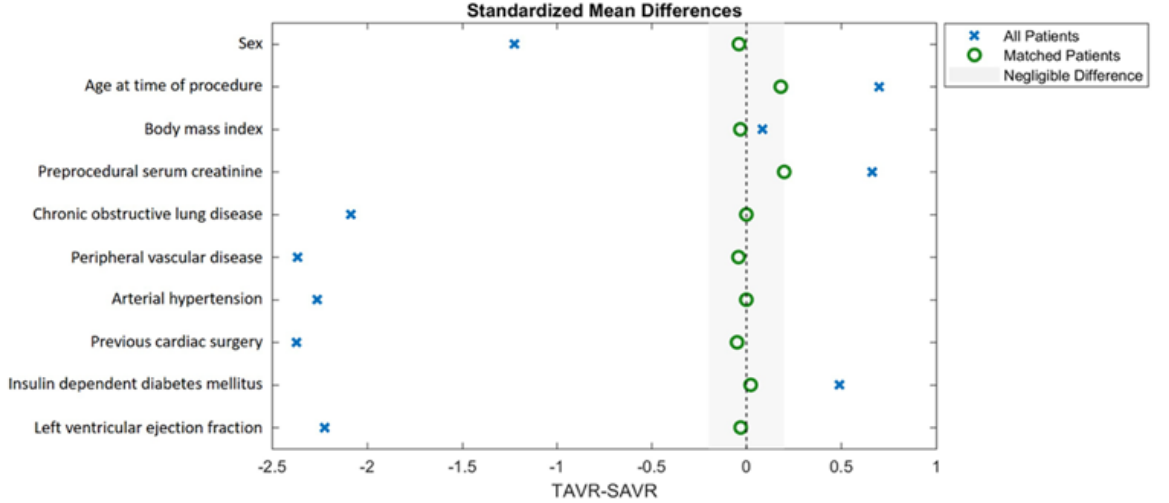
Figure 2. Standardized mean differences in matching variables before and after propensity score matching.